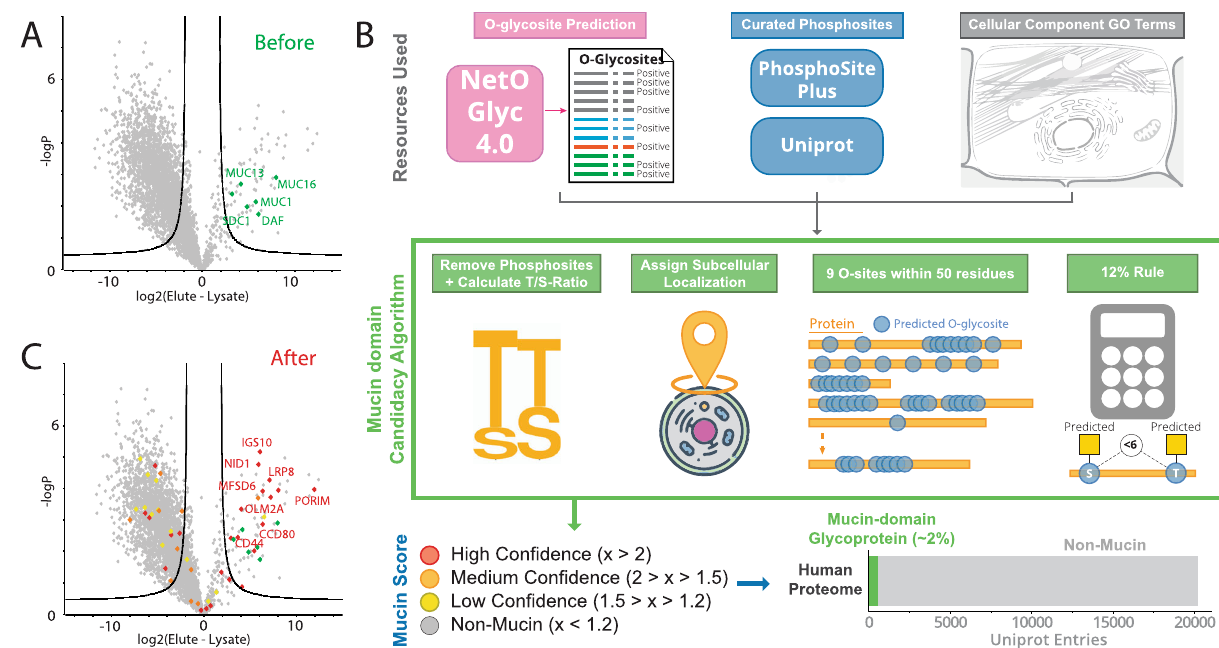
Fig. 2 Mucin-domain candidacy algorithm for con fi dent assignment of mucin-domain glycoproteins. A Known mucins in HeLa lysate enrichment. HeLa lysate was subjected to the enrichment procedure described in Fig. 1 and known mucin-domain glycoproteins (MUC1, MUC13, MUC16, DAF, and SDC1) were labeled. Source data are in Supplementary Data 3. Signi fi cance testing was performed using a two-tailed t -test with 250 randomizations to correct for multiple comparisons, an FDR of 0.01, and an S0 value of 2. B Mucin-domain glycoprotein candidate annotation. A mucin-domain candidacy algorithm was created to assign Mucin Scores to indicate con fi dence that a given protein contains a mucin domain. First, predicted O-GalNAc sites were generated by the NetOGlyc4.0 tool, curated lists of phosphosites were downloaded from PhosphoSitePlus and Uniprot, and cellular localization GO terms were downloaded. The mucin-domain candidacy algorithm then removed predicted O-GalNAc sites overlapping with known phosphosites, calculated the proportion of threonine to serine residues (T/S-ratio), evaluated protein subcellular localization, and checked for frequency and density of predicted O-GalNAc sites. These metrics were used to calculate a Mucin Score, which could then be used to evaluate mucinome enrichment. The entire human proteome was processed with the mucin-domain candidacy algorithm; using manually curated benchmarks, 357 proteins have mucin domains (~2% of human proteome). The cell image is licensed through a CC BY 4.0 license from the Uniprot database 52 . C Mucinome of HeLa lysate. The results in A were processed with the mucin domain de fi nition program, and mucin-domain glycoproteins were labeled according to the Mucin Score. Red signi fi ed a score of >2 (high con fi dence), orange 2 – 1.5 (medium con fi dence), and yellow 1.5 – 1.2 (low con fi dence). Known mucin-domain glycoproteins labeled in A are still labeled in green. Source data are in Supplementary Data 3. Signi fi cance testing was performed using a two-tailed t-test with 250 randomizations to correct for multiple comparisons, an FDR of 0.01, and an S0 value of